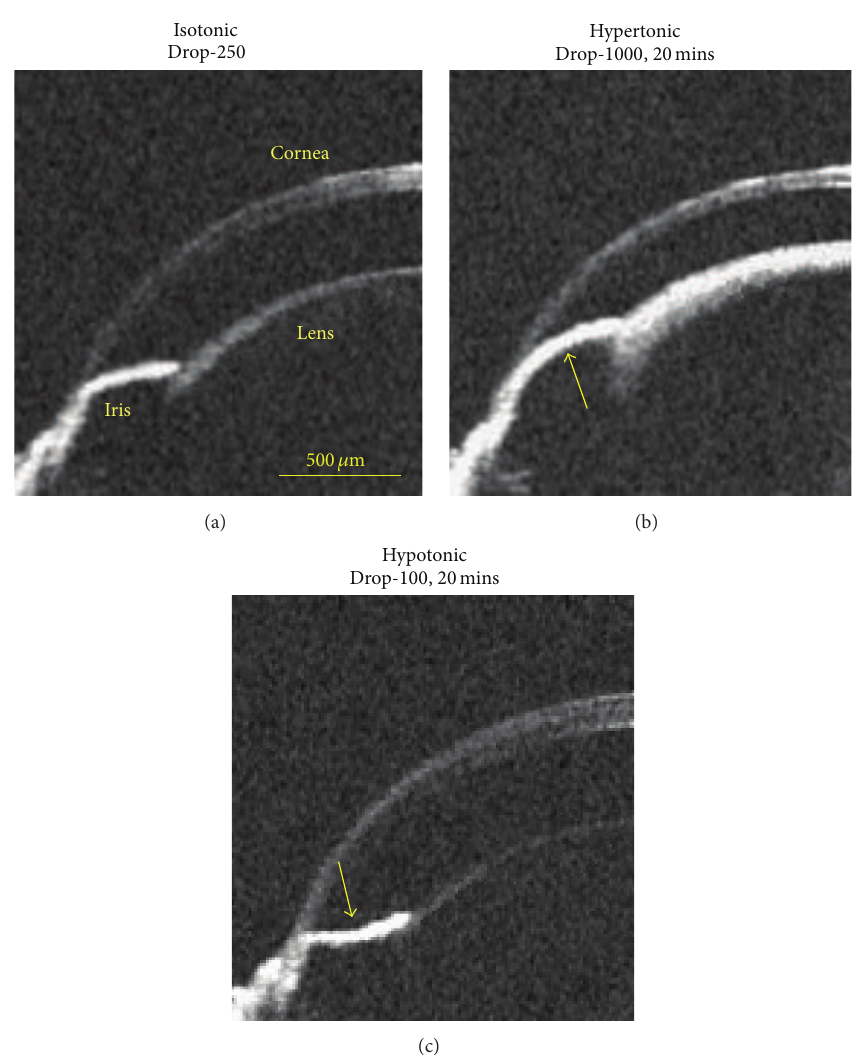
Figure 3: Iris response to osmotic challenges indicating the IOP change. (a) Isotonic phase. (b) Hypertonic phase at the time instant of 20 mins after the administration of Drop-1000 challenge. (c) Hypotonic phase at the time instant of 20 mins after the administration of Drop- 100 challenge. The bold arrows indicate the possible direction of the IOP-induced force that acted on the